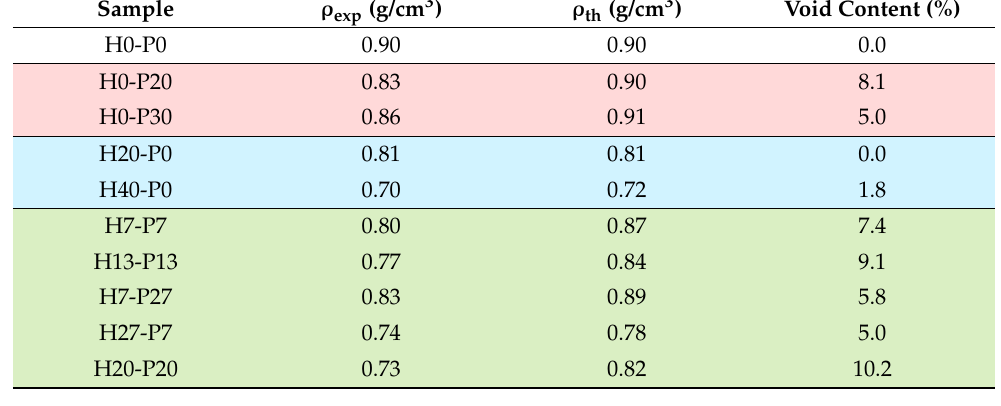
) from flow sweep rheological tests on the γ(cid:3)